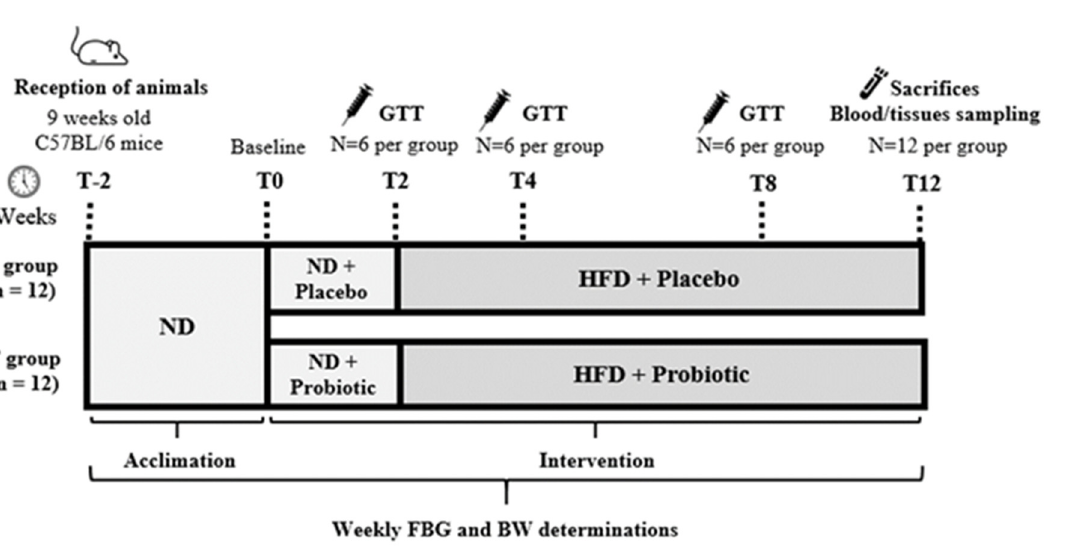
Figure 1. Experimental design. BW: body weight; FBG: fasting blood glucose; GTT: glucose tolerance test; HFD: high-fat diet; ND: normal diet.